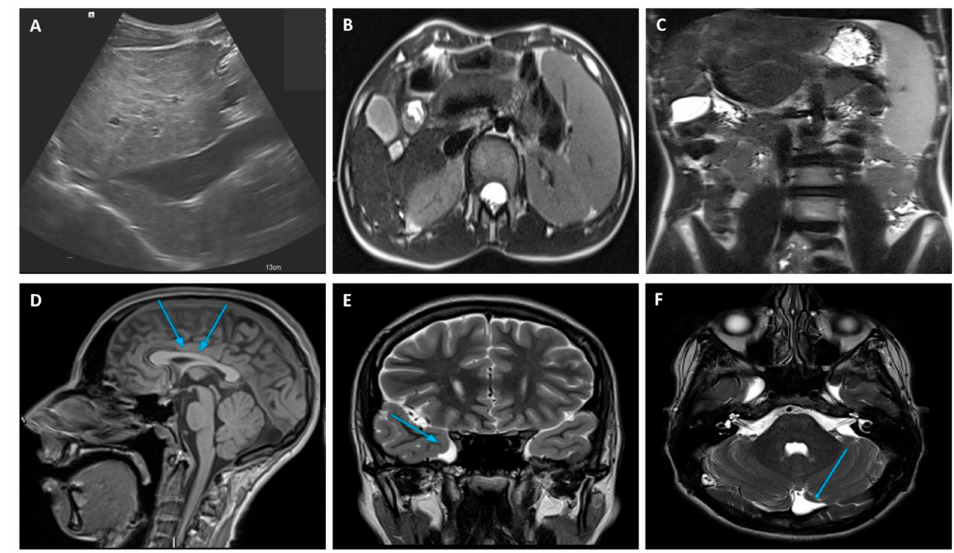
Figure 1. Liver doppler ultrasound ( A ) and abdominal MRI ( B ) findings showing hepatic parenchy- mal micro- and macronodular transformation with associated splenomegaly ( C ). MRI brain abnor- malities: ( D ) mild hypoplasia of the rostrum and splenium of the corpus callosum, ( E ) temporo-polar arachnoid cyst, ( F ) retro-infero-cerebellar arachnoid cyst. MRI, Magnetic Resonance